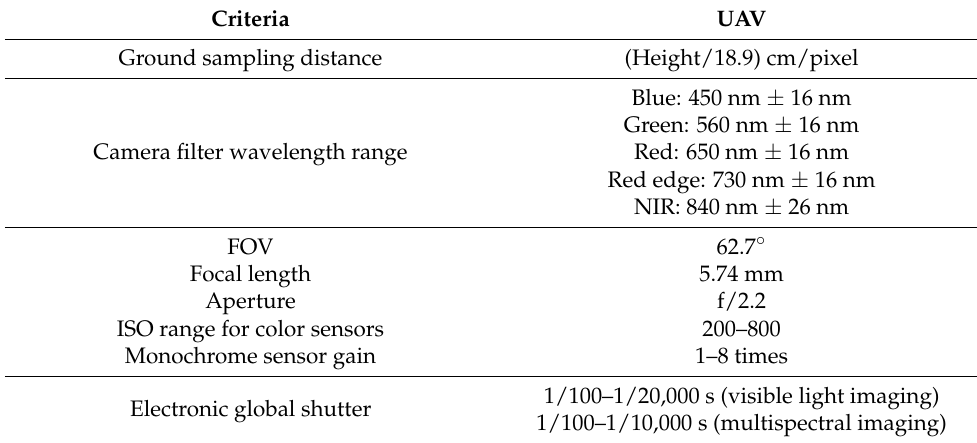
Table 1. Specifications of the DJI Phantom 4 Multispectral UAV.